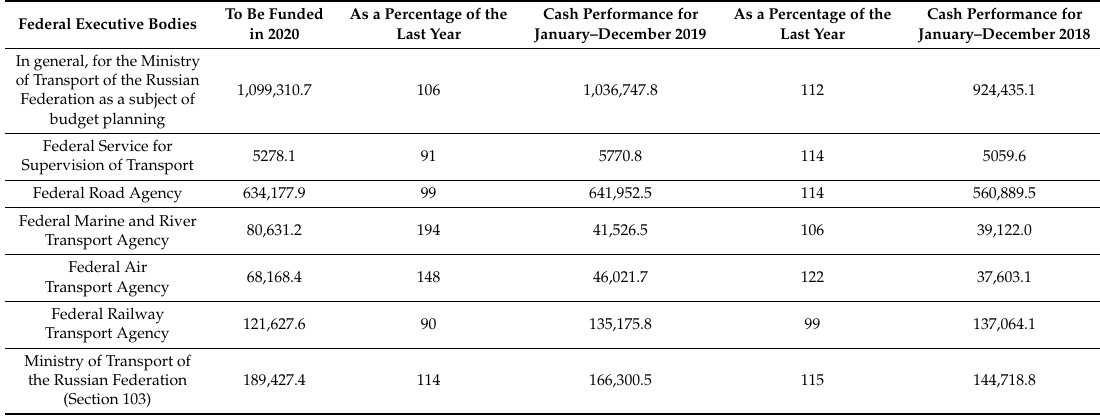
Table 4. The federal budget performance in the sphere of transport in 2020 (million rubles)